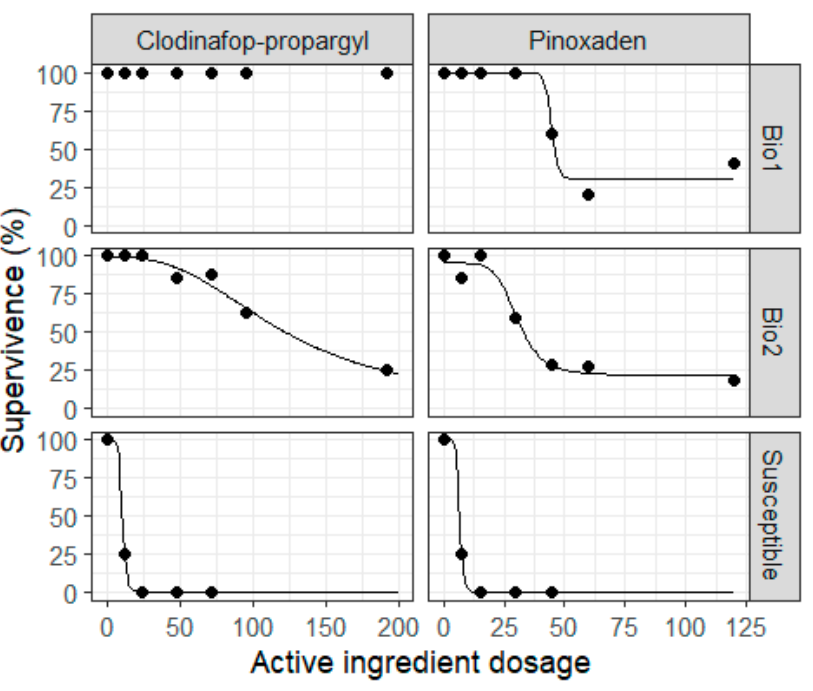
Figure 1. Dose-response of each population to both active ingredient doses. The black points represent the observed results and the lines indicate the logistic regression for each situation. Table 2. Values of herbicide rate required to achieve the 50% (LD 50 ) and 90% (LD 90 ) mortality for each herbicide and population. The resistant factor (RF) is also presented for both parameters.